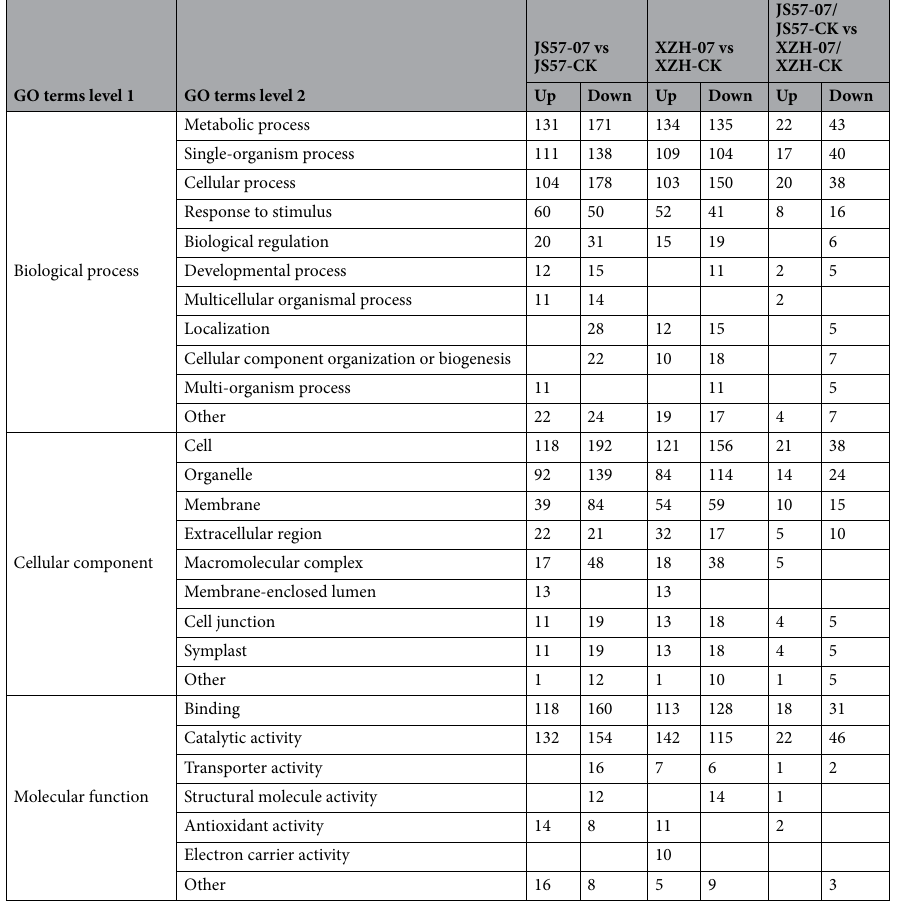
Table 2. The numbers of up- and down-regulated proteins of GO